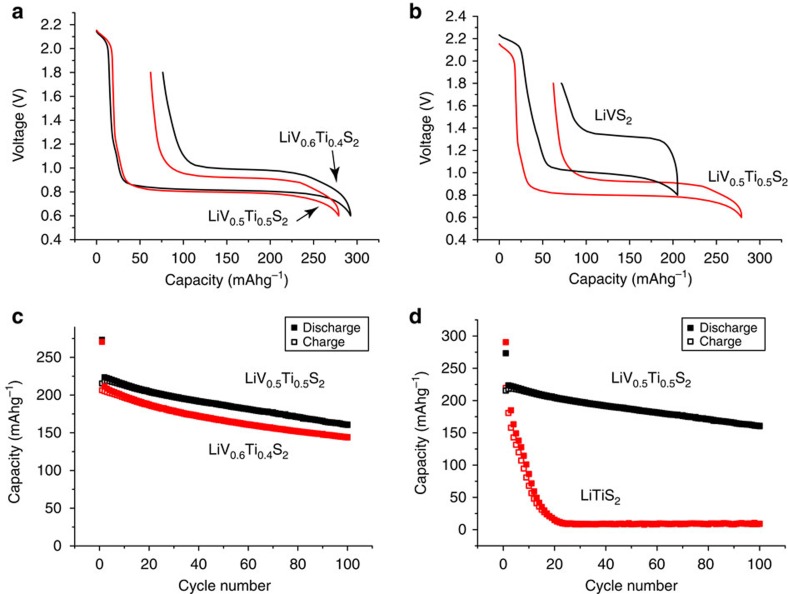
Comparisons between Li(V0.5Ti0.5)S2 and other members of the Li(V1-xTix)S2 solid solution.(a,b) show the variation of potential with state-of-charge on the 1st cycle for Li(V0.5Ti0.5)S2 and Li(V0.6Ti0.4)S2, and LiVS2 respectively. (c,d) show the variation of capacity with cycle number for Li(V0.5Ti0.5)S2 and Li(V0.4Ti0.6)S2, and LiTiS2 respectively, Closed squares correspond to intercalation and open squares to deintercalation. All data were collected at a rate of 100 mAg−1.